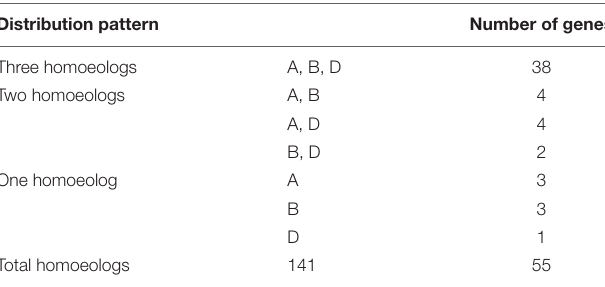
TABLE 1 | Distribution pattern of TaDEAD-box homoeologs.